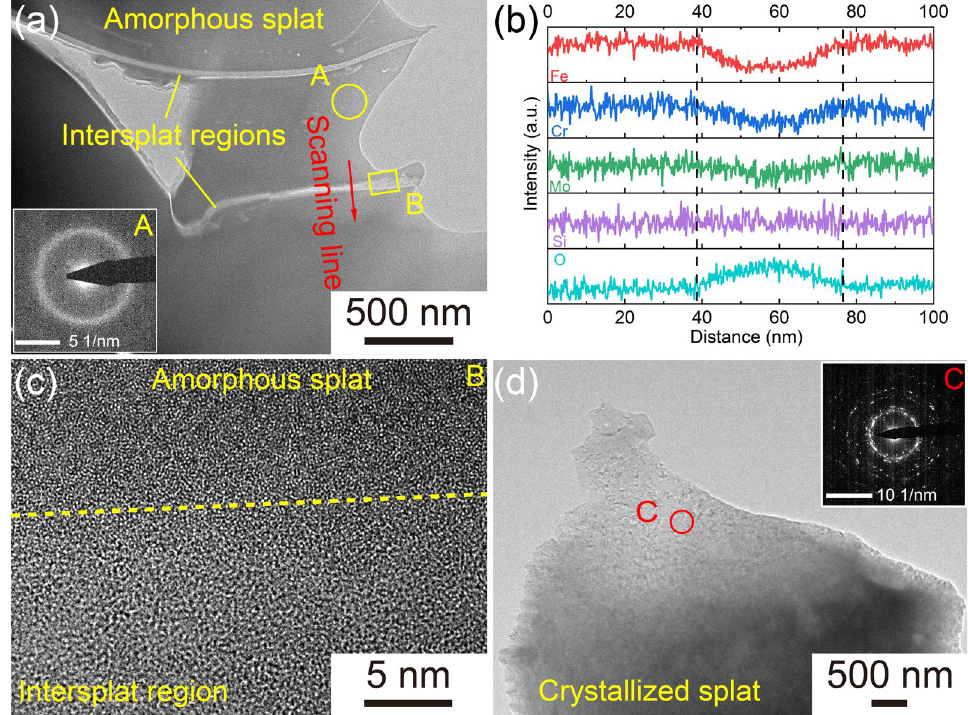
Figure 2. ( a ) TEM image of the amorphous splats in AMCs; ( b ) EDS line scanning profiles of the intersplat region marked in ( a ); ( c ) HREM image of Zone B (the intersplat region) marked in ( a ); ( d ) TEM image of the crystallized splats in AMCs; The insets in ( a , d ) are the SAED patterns of Zone A and C, respectively.